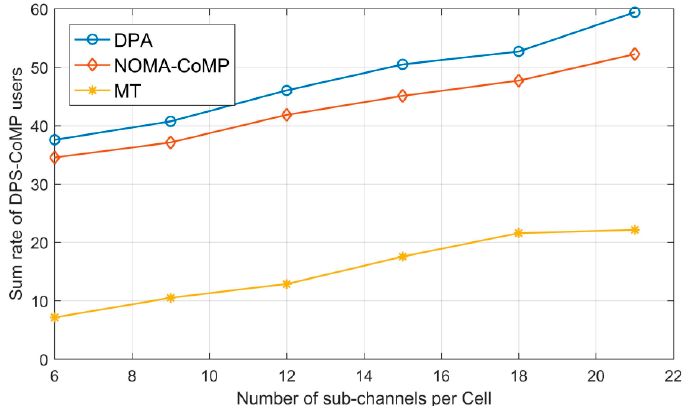
Figure 4. Sum rate of DPS-CoMP users (Mbps) versus the number of subchannels per cell [82].